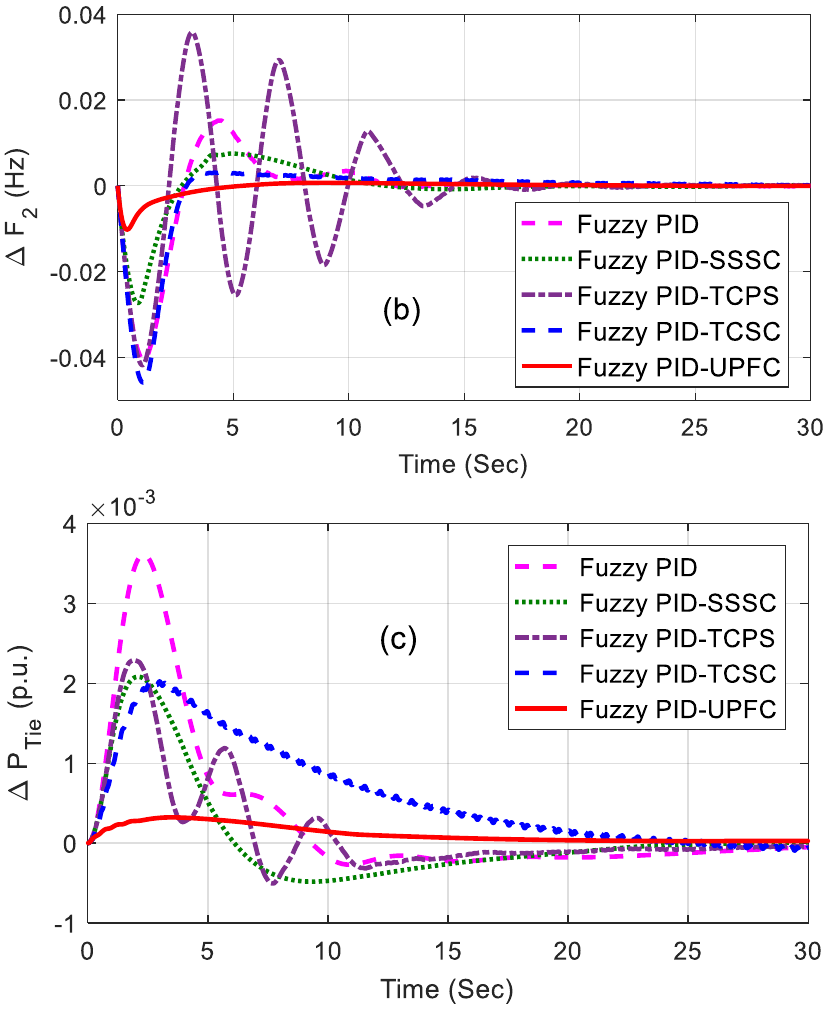
Figure 7. ( a – c ) Dynamic performance of 1% SLP in area2. Table 4. Eigen values of the proposed